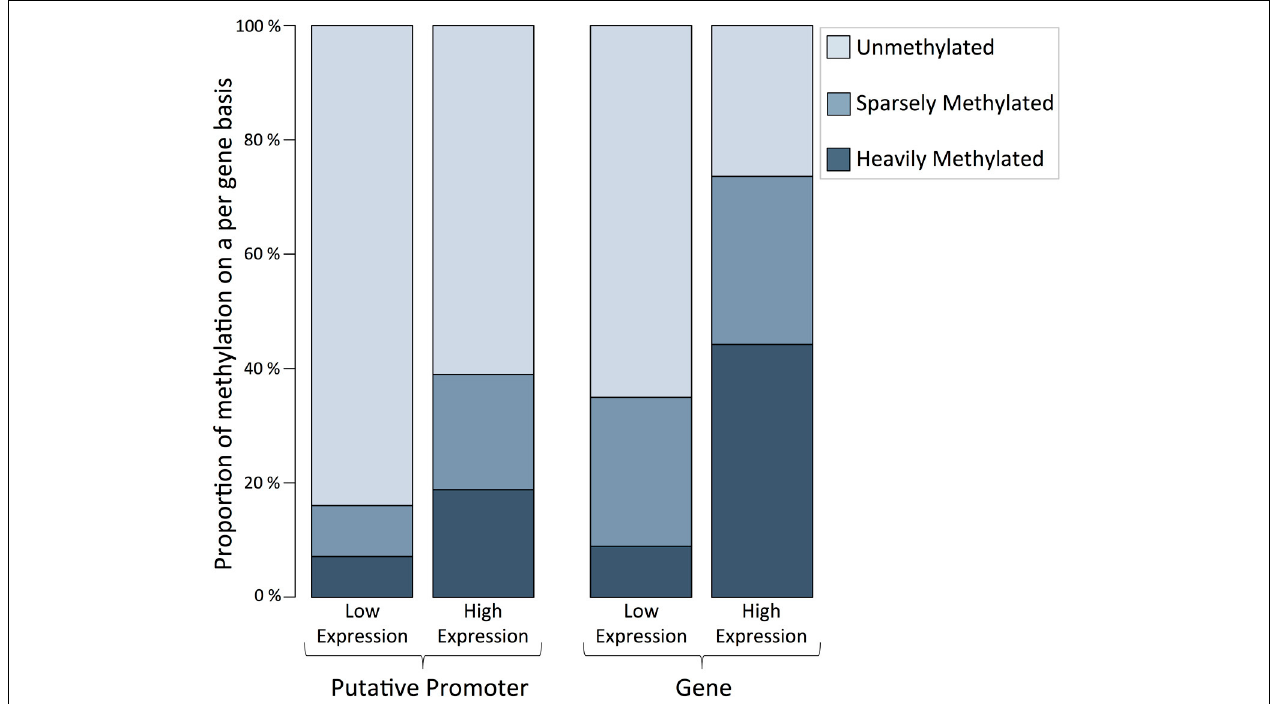
FIGURE 3 | Proportion of methylation on a per gene basis for putative promoter regions and gene bodies (exon and introns) for high and low expression levels indicate that DNA methylation is positively correlated to gene expression in C. gigas male gamete tissue. Two classifications shown include genes with of low expression (Promoter regions = 13,919 and